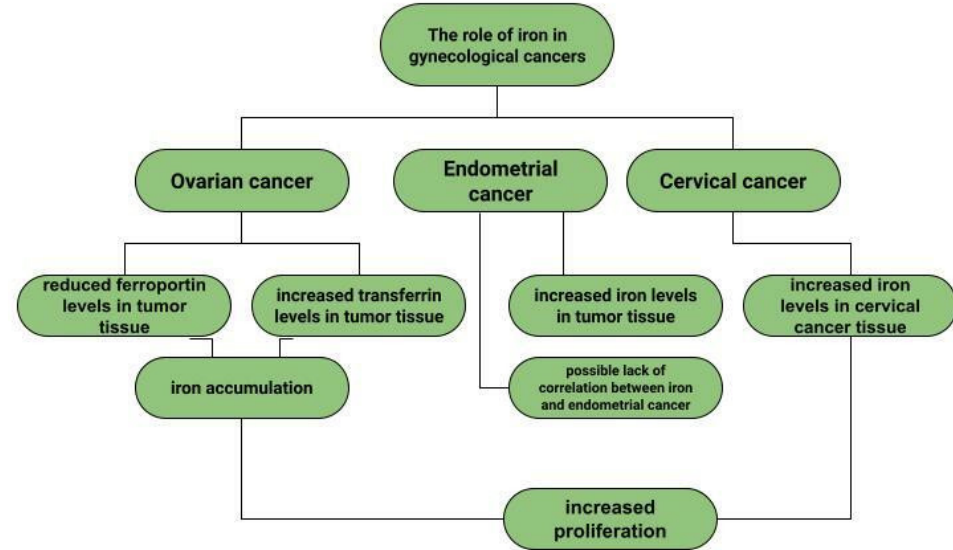
Figure 1. The role of iron in gynecological diseases.